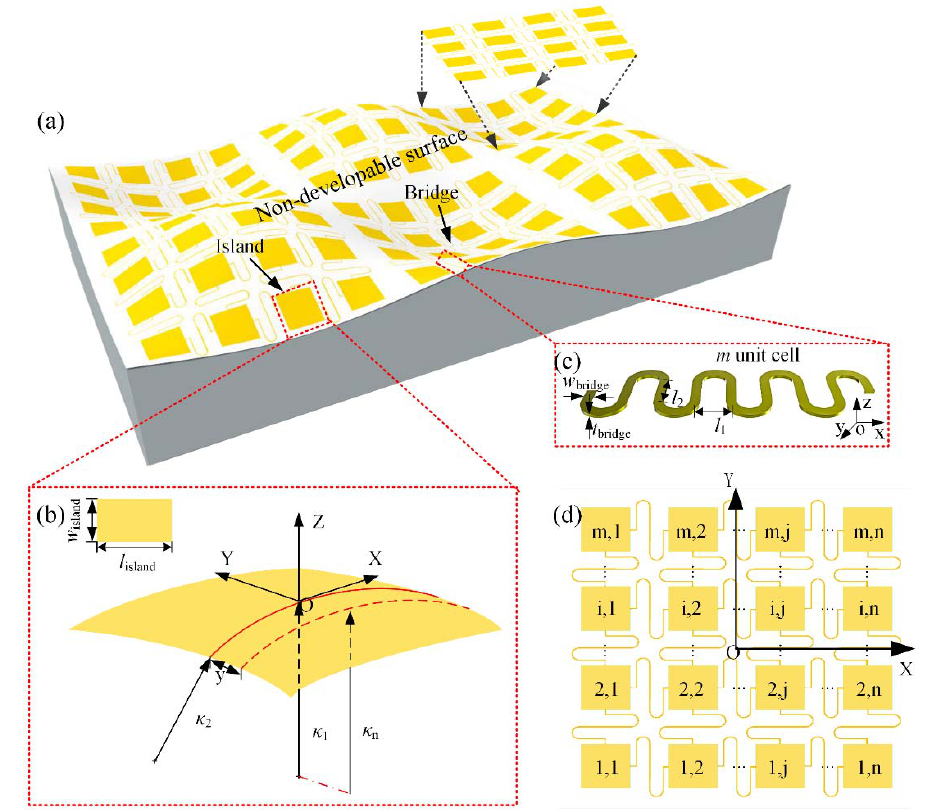
Figure 1. ( a ) An island ‐ bridge structure array on a non ‐ developable surface; ( b ) theory model of island on a torus surface under control by two principal curvatures, κ 1 and κ 2 ; ( c ) schematic of geometric parameters for a serpentine bridge with m unit cells; ( d ) a numbered island ‐ bridge structure array with m rows and n columns of islands.